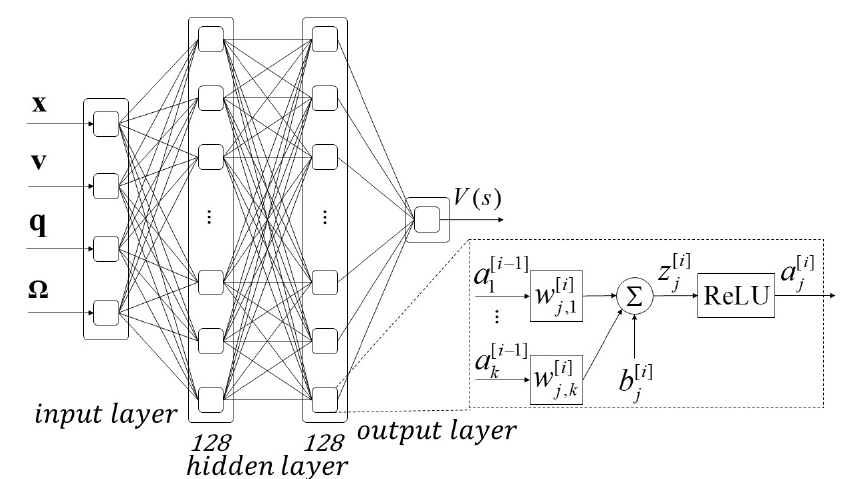
Figure 2. Value function using neural network approximation; the function consists of two hidden layers with 128 rectified linear unit nodes in each layer. The input is the state of vehicle, where x , v , q and Ω are the position, velocity, quaternion, and angular velocity, and the output is the estimated value of state V ( s ) .